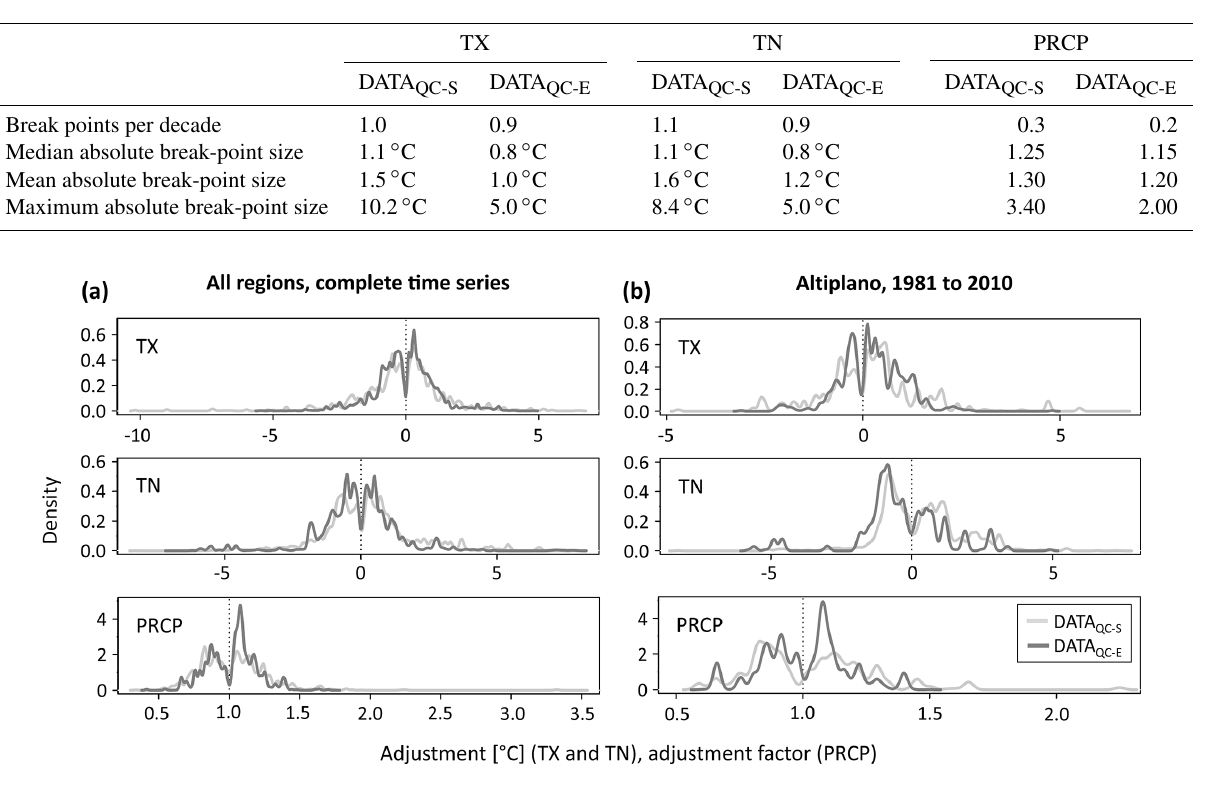
Figure 6. Kernel density of the adjustments calculated with ACMANT3 for all regions and the complete time series (a) and for the Altiplano stations from 1981 to 2010 (b) . For maximum and minimum temperature (TX and TN, respectively), inhomogeneous time series segments are corrected by adding the adjustment values, whereas for precipitation (PRCP), inhomogeneous segments are corrected by multiplication with the adjustment